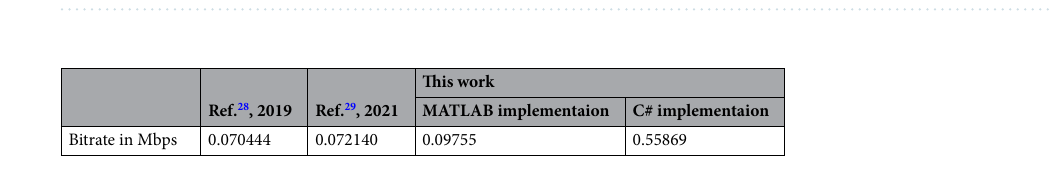
Table 6. Comparison between iterative methods and this work.